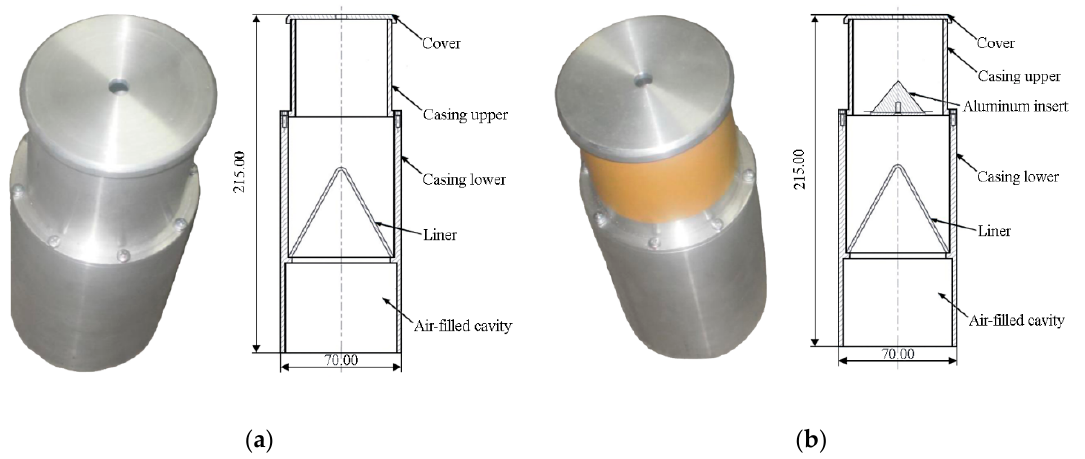
Figure 3. Cumulative charges prepared for testing: ( a ) axial of cumulative charge; ( b ) peripheral of cumulative charge.